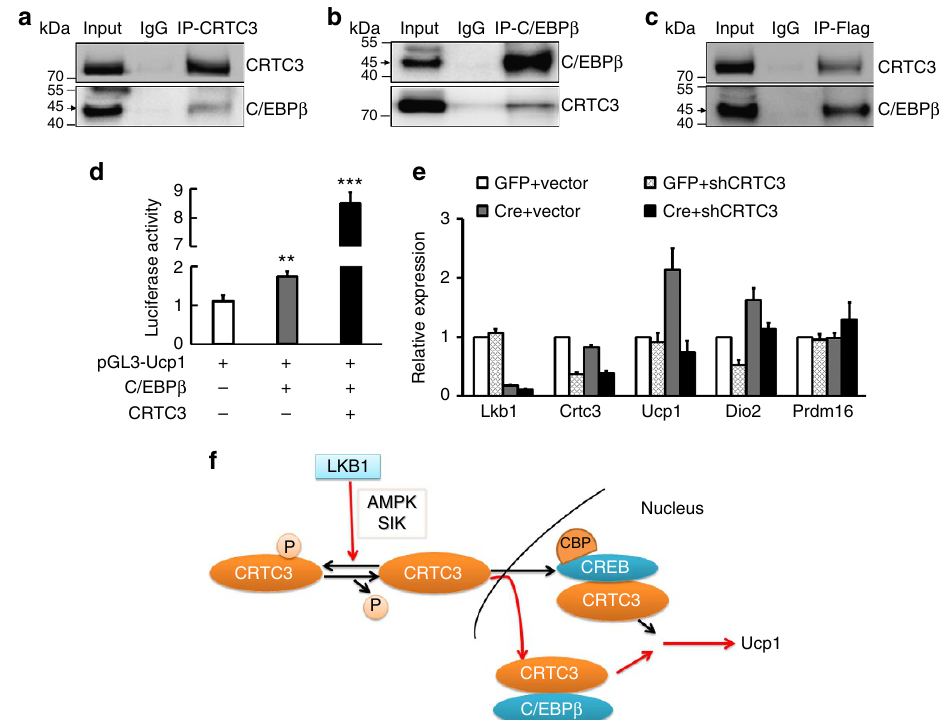
Figure 6 | CRTC3 binds to C/EBP b to enhance its transcriptional activity. ( a – c ) CRTC3 interacts with C/EBP b . 293T cells were co-transfected with pcDNA-Flag-CRTC3 and pcDNA-C/EBP b , then immunoprecipitated (IP) with CRTC3 ( a ), C/EBP b ( b ) and Flag ( c ) antibodies, followed by Immunoblotting (IB) with CRTC3 and C/EBP b antibodies. ( d ) Luciferase assay of 293T cells after co-transfected with the plasmids shown. n ¼ 4. ( e ) CRTC3 shRNA knockdown abolishes the effects of Lkb1 deletion on Ucp1 expression. BAT preadipocyte from Lkb1 flox/flox mice were infected with adenovirus expressing GFP or Cre, plus adenovirus carrying LacZ or CRTC3 shRNA. After differentiation, total RNA was extracted for Real-time PCR analysis. Error bars represent s.e.m. n ¼ 4, ** P o 0.01, P o 0.001. ( f ) A model depicting Lkb1’s role in regulating the localization and function of CRTC3. Red arrows indicate novel pathways shown in this study and black arrows indicate previously published pathways. NATURE COMMUNICATIONS|7:12205|DOI: